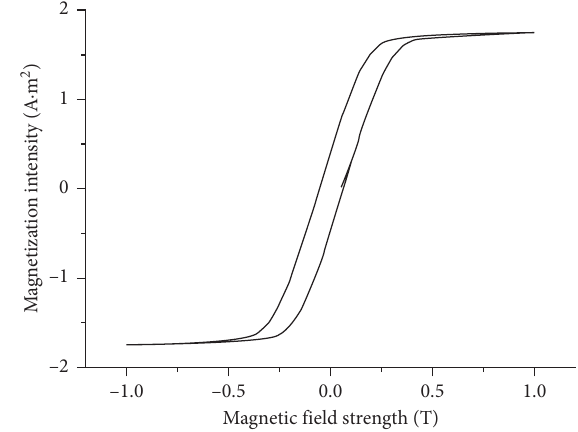
Figure 1: Magnetization curve of bridge steel